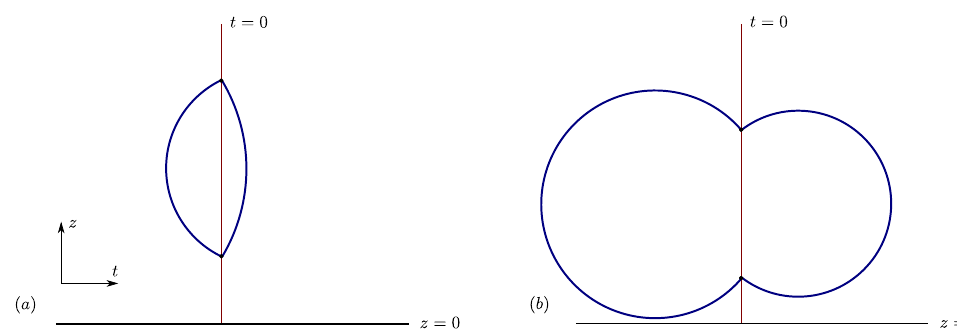
Figure 4 . Positive mass makes the cusps turn inward (b), negative mass turns them outward